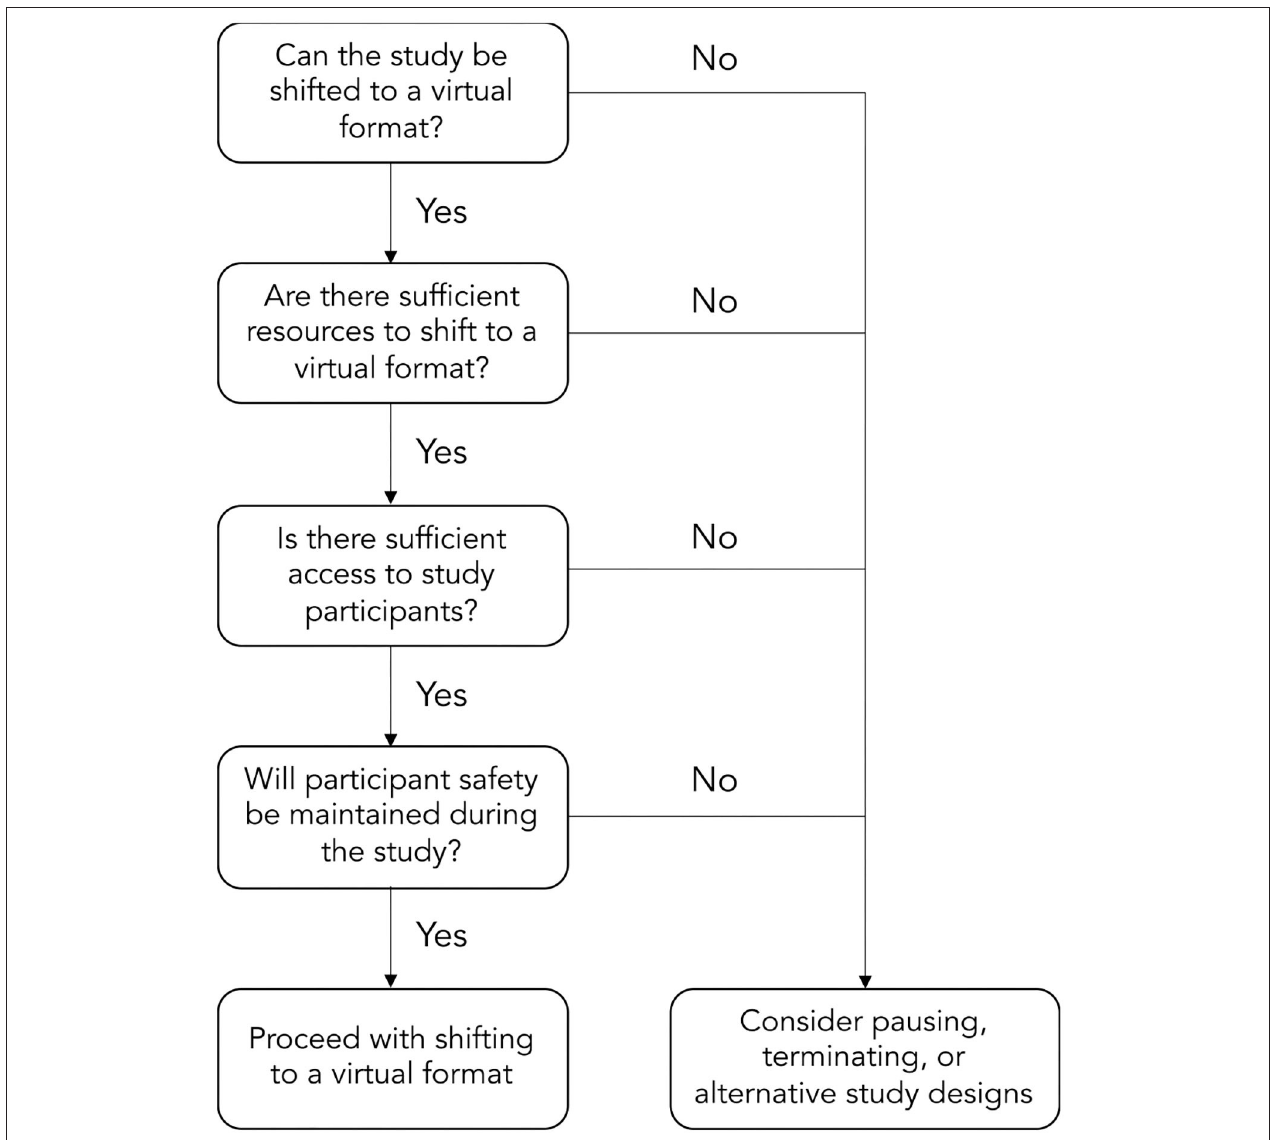
FIGURE 1 | Potential flow of decisions to shift to a virtually-delivered rehabilitation